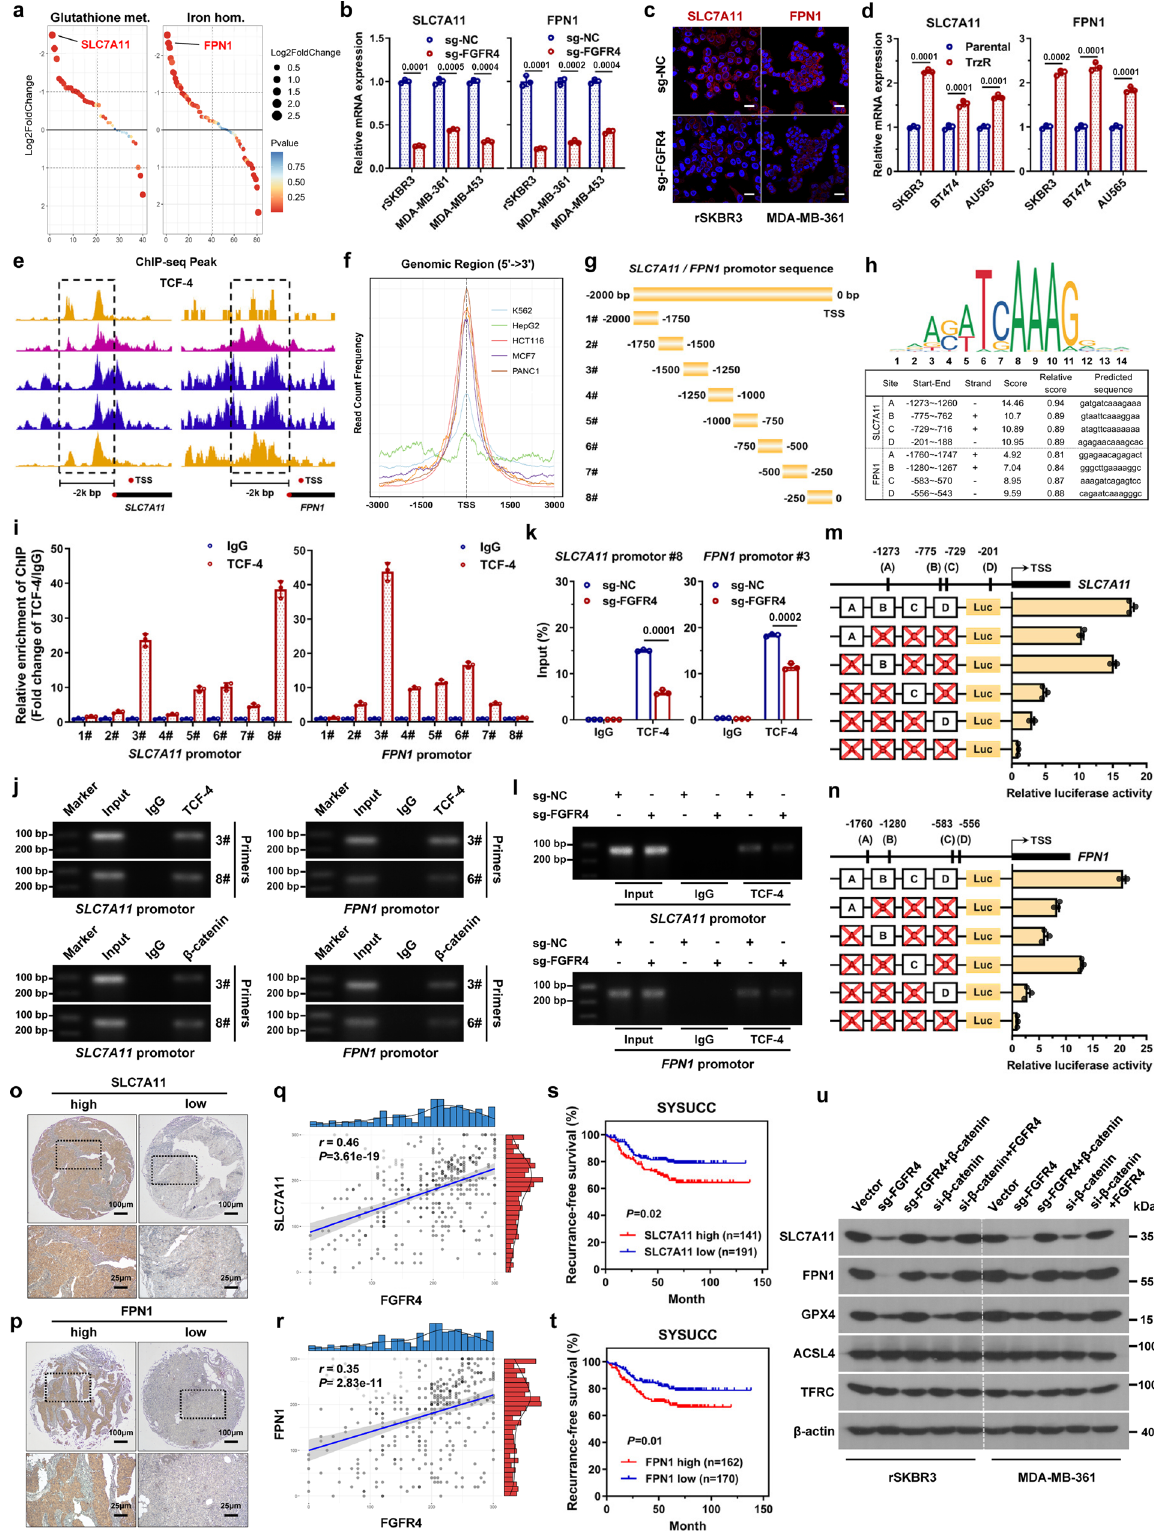
and HEK293T cell line were purchased from the American Type Culture Collec- tion and cultured following the manufacturer ’ s instructions. rSKBR3, rBT474, and rAU565 cells were developed by three-month exposure and selection with 1 μ M trastuzumab. These acquired trastuzumab-resistant cell lines were continuously cultured in the regular medium with trastuzumab which was withdrawn four weeks before experiments. Cell lines were passaged for no more than six months and were authenticated by STR analysis. No mycoplasma infection was found for any